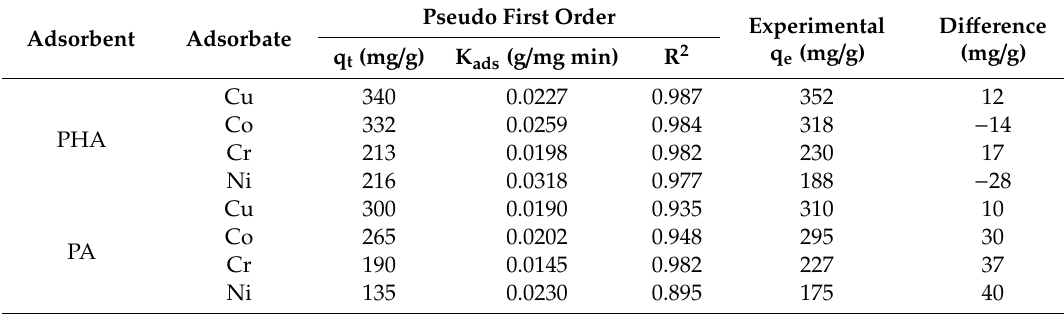
Table 1. Adsorption rates of the pseudo first-order model for transition metals by the polymer ligands (PHA / or PA ligand).